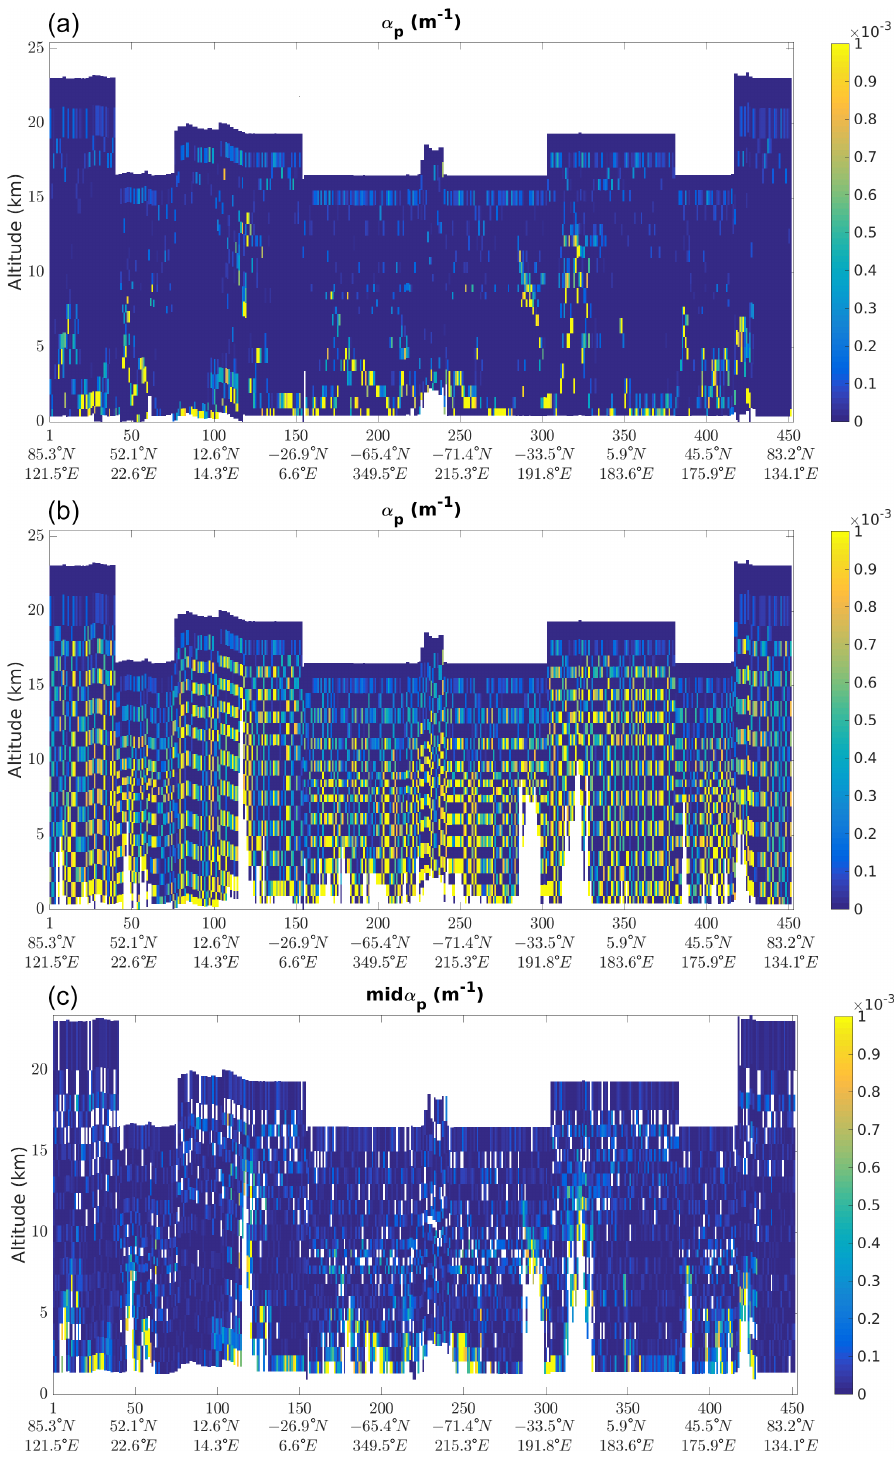
Figure 11. The extinction retrieved with the SCA (a) and with a modification that cancels the reset of negative values to 0 in the iterative retrieval process (b) . The resulting oscillation due to the downward propagation of errors is obscuring any useful information. The mid-bin retrieval is shown in the bottom panel (c)